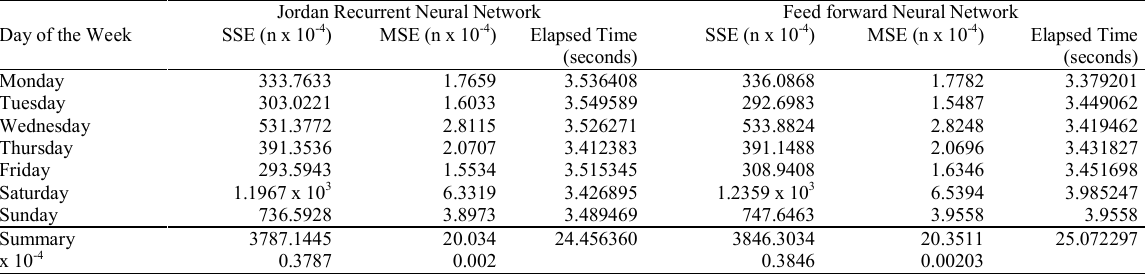
TABLE 3 SSE AND MSE V ALUES AND E LAPSED T IME OF T HE T EST R